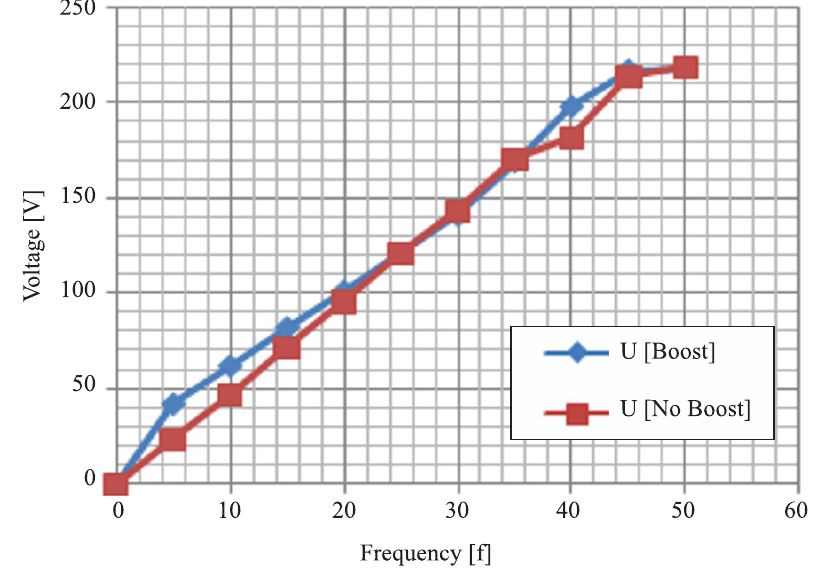
FIG. 27. VOLTAGE V/S FREQUENCY